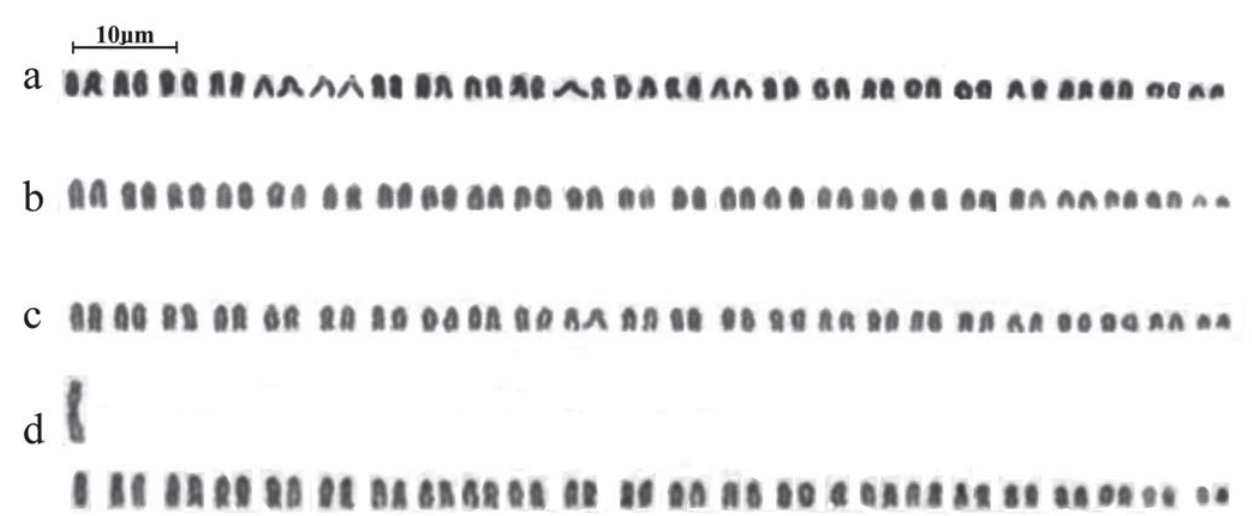
Fig. 1. Giemsa-stained karyotypes of Lutjanus analis (a), L. griseus (b), L. synagris cytotype I (c) and L. synagris cytotype II (d).